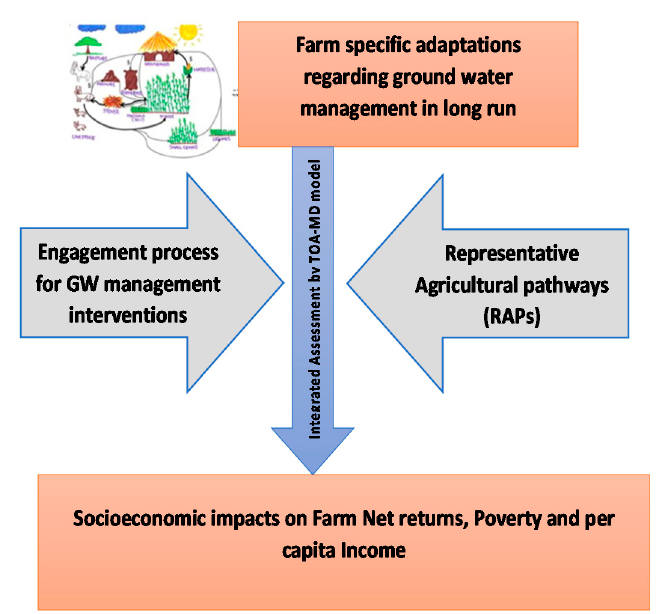
Figure 5. Research framework regarding ground water management